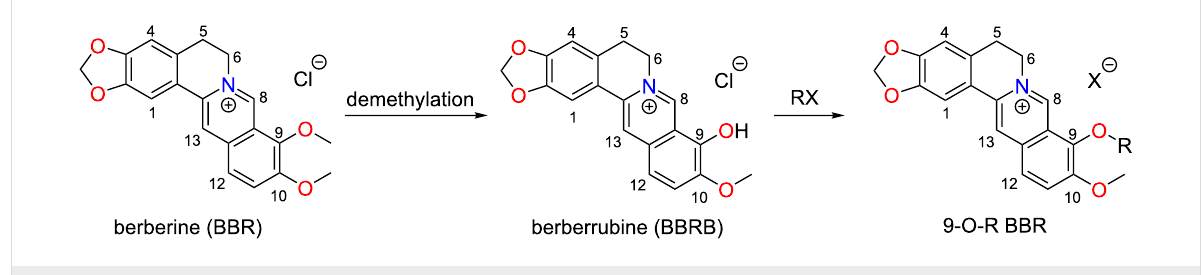
Scheme 1: Synthetic pathway of 9-O-R BBR.